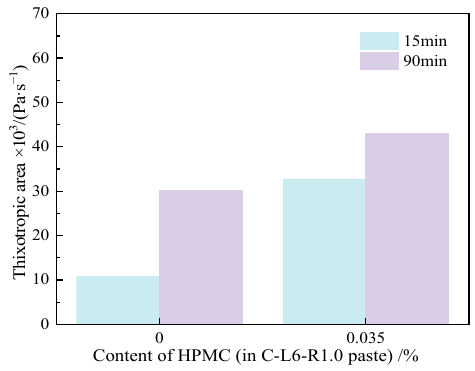
Figure 21. Thixotropic area of C-L6-RPP-R1.0-HPMC pastes. The paste mixed with HPMC shows shear thinning during the whole rheological test.